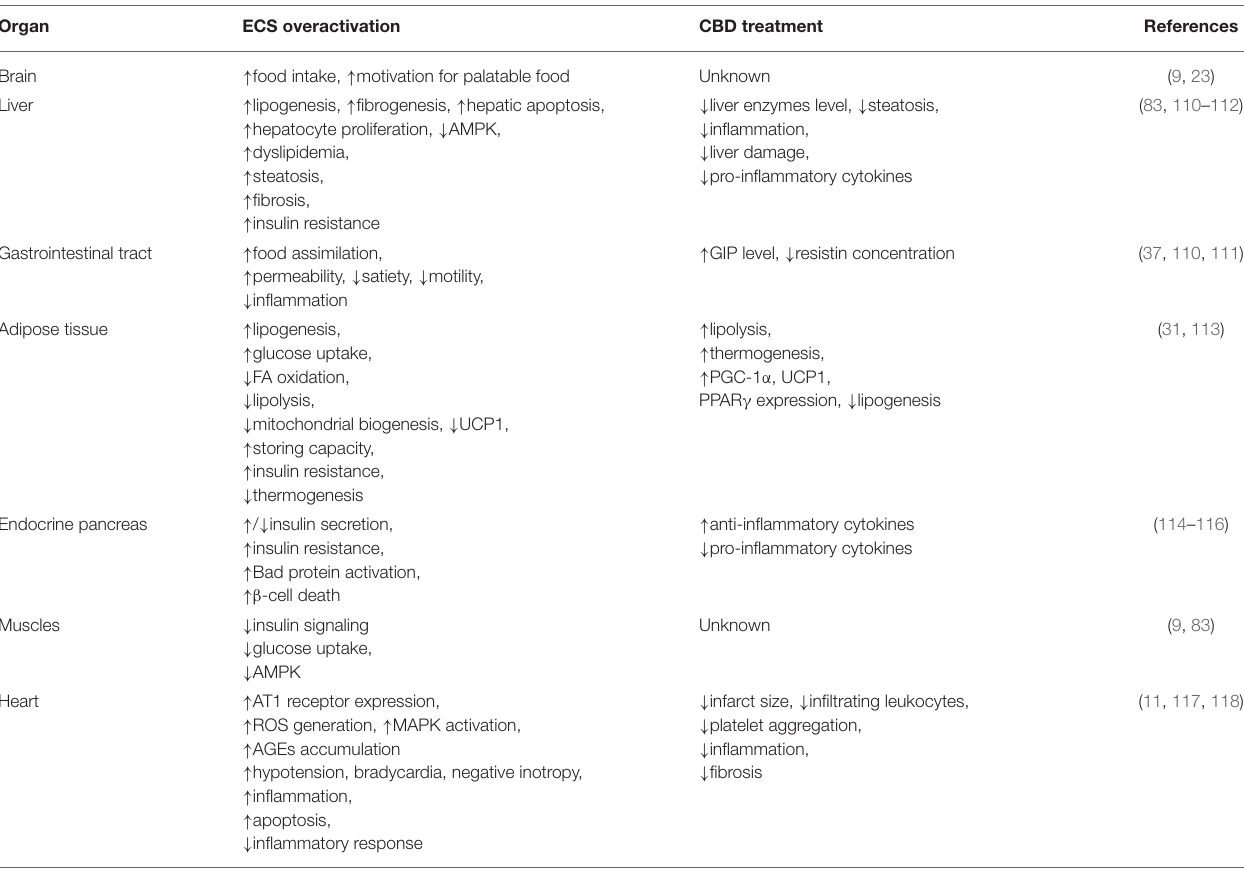
TABLE 1 | Summary of the effects of CBD on different tissues during